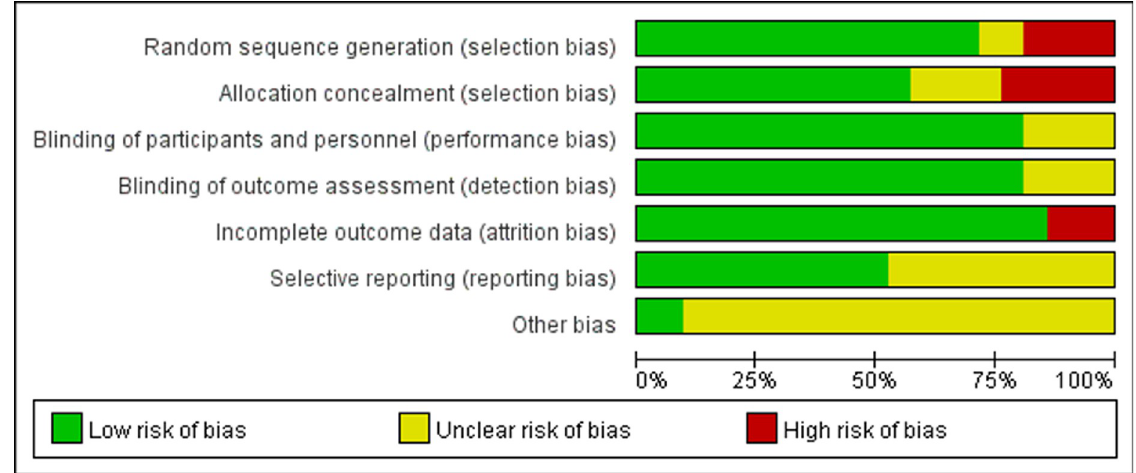
Fig 2. Risk assessment graph based on Cochran’s quality evaluation